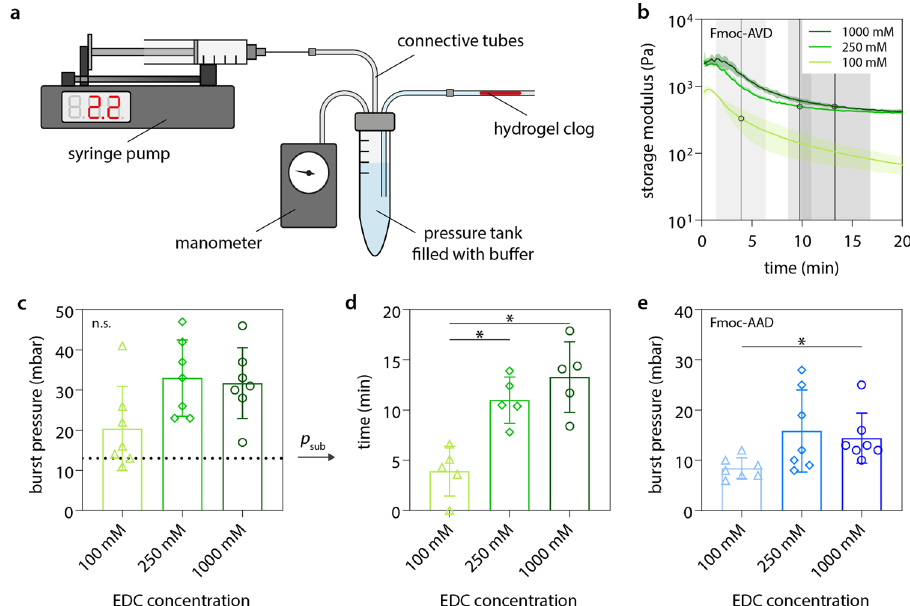
Fig. 3 Transient clogging of tubings. Schematic illustration of the fl uidic system used to conduct the clogging experiments ( a ). The pressure resistance of clogs formed by Fmoc-AVD and Fmoc-AAD hydrogels in macroscopic tubings depends on the fuel concentration ( c , e ). If Fmoc-AVD hydrogel clogs are exposed to a subcritical pressure (black dashed line in c ), they withstand this mechanical load for a certain, fuel-dependent time span ( d ). This time span re fl ects the time point in the gelation curves where the gel stiffness falls below a critical value (circles in b ). Data shown represents the mean and the standard deviation as obtained from n = 3 ( b ), n = 7 ( c , e ), and n = 5 ( d ) independent samples. The level for signi fi cance was set to p < 0.05 and determined by ordinary one-way ANOVA and Tukey post hoc test ( c , d ) or Kruskal – Wallis test in combination with the Dunn ’ s multiple comparisons test ( e ). Fmoc-AVD data is depicted in green and Fmoc-AAD data in blue. Bright colors represent an EDC concentration of 100 mM, medium bright colors correspond to 250mM, and dark colors to 1000 mM. Individual data points are depicted with triangles (100 mM EDC), rhombuses (250 mM EDC), and circles (1000